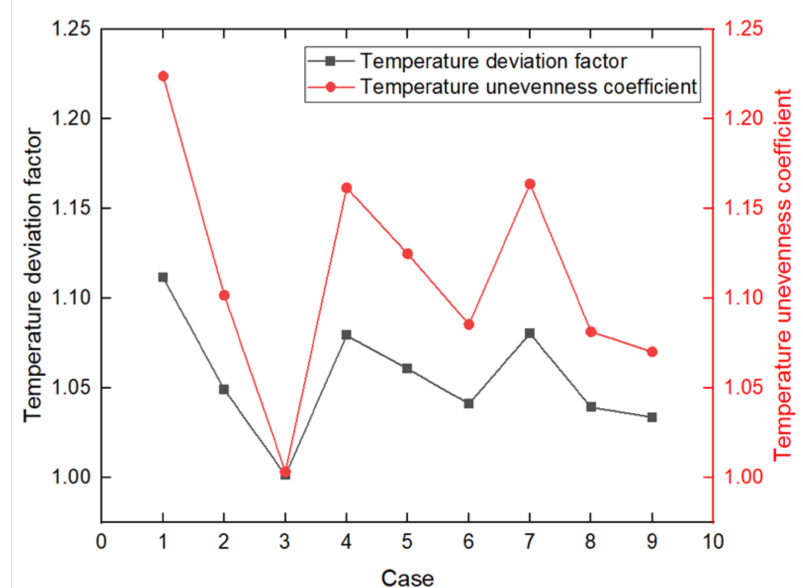
Figure 9. P4 section temperature